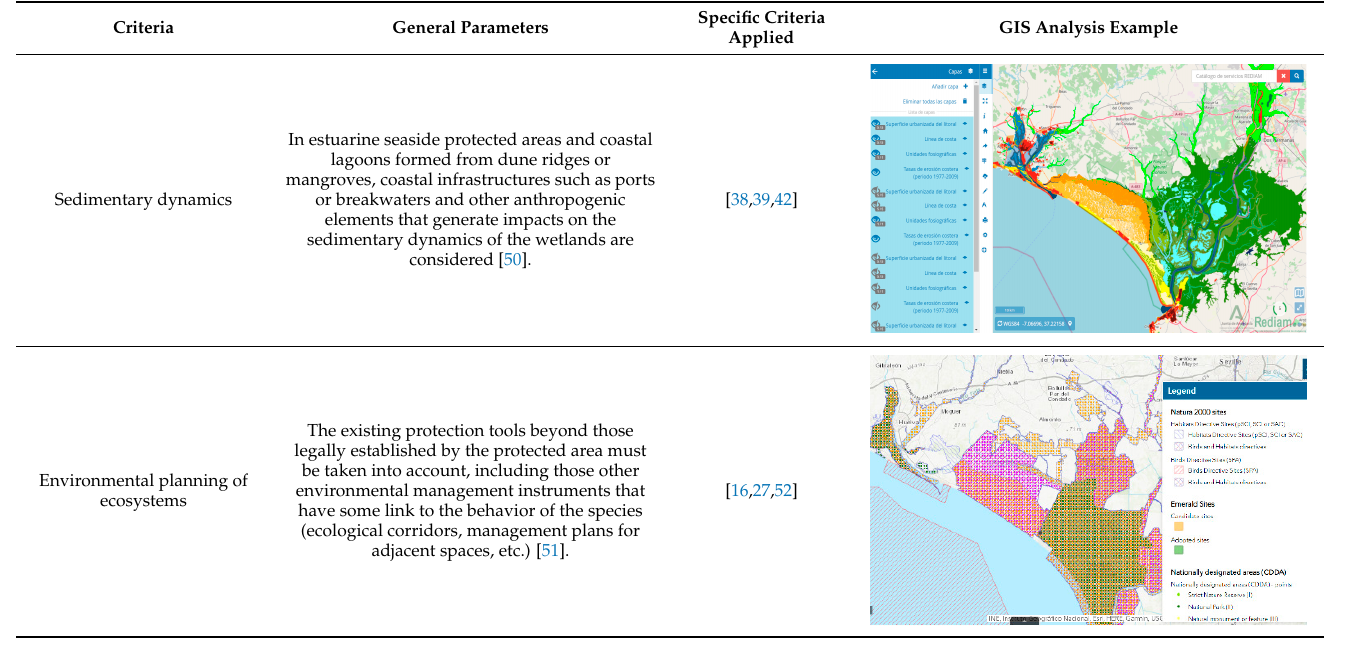
Figure 7. Area of influence of diffuse anthropization in the Doñana National Park.